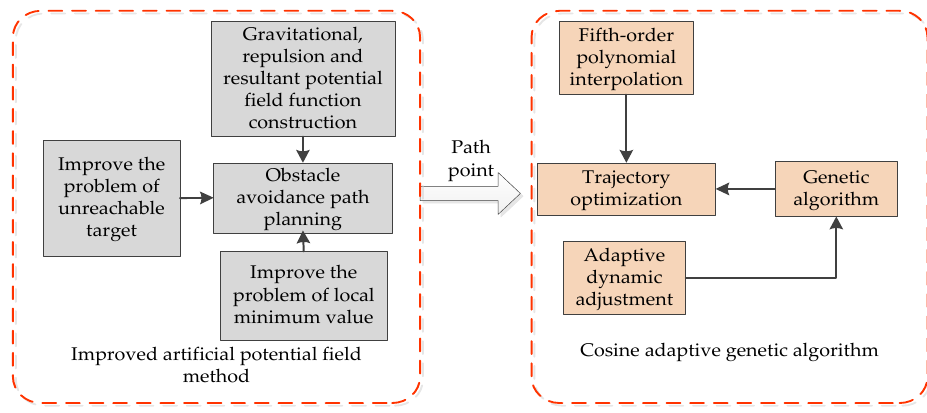
Figure 1. Trajectory optimization of the pickup manipulator in the obstacle environment.